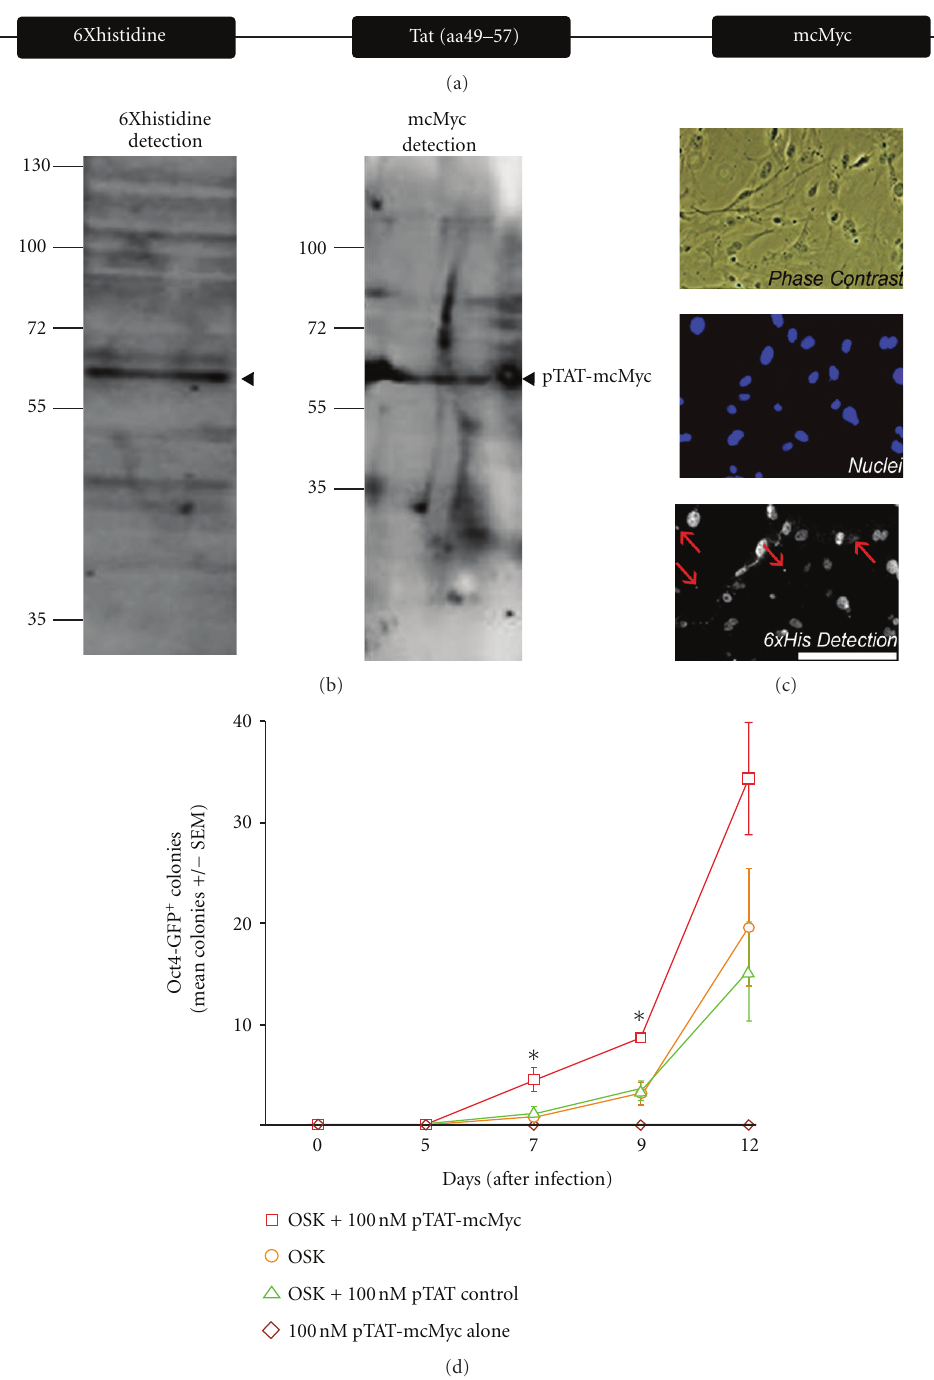
Figure 2: Construction and transduction of of pTAT-mcMyc recombinant protein to MEF in vitro . (a) Schematic representation of the pTAT-mcMyc construct. (b) Reduced and denatured pTAT-mcMyc recombinant protein was resolved on 12–15% SDS-polyacrylamide gel and transferred to PVDF membrane by electrophoresis (90 V, 2 hours, 4 ◦ C). Wet membrane was blocked for 1 hour in Odyssey blocking bu ff er (1:1 Tris-HCl bu ff er) and probed with either mouse anti-6xHistidine or mouse anti-mouse cMyc primary antibody before detection with goat anti-mouse Alexa Fluor-680 secondary antibody. Recombinant pTAT-mcMyc was detected at predicted molecular weight (57– 60kDa; arrow). (c) MEFs were plated to coverslips before 100 nM pTAT-mcMyc recombinant protein was applied to equilibrated culture media. Following a 1-hour incubation, MEFs were washed, fixed, blocked, and probed with antibody recognizing 6xHistidine (bottom panel). Cell nuclei were detected with Hoechst dye (middle panel). Scale bar: 200 μ M. Red arrows shown detection of pTAT-mcMyc protein outside of detectable nuclei. (d) MEFs were infected with retrovirus harboring OSK or left uninfected. OSK-expressing MEFs were treated with 100 nM pTAT-mcMyc protein (red square) or pTAT-control protein (green triangle) daily for 12 days. Uninfected MEFs were left as a control, or treated with 100 nM pTAT-mcMyc protein (brown diamond) daily for 12 days. On days 5, 7, 9, and 12 after infection, Oct4-GFP + colonies were counted in duplicate wells. Mean ± SEM of n = 4 independent experiments shown; P < 0 .